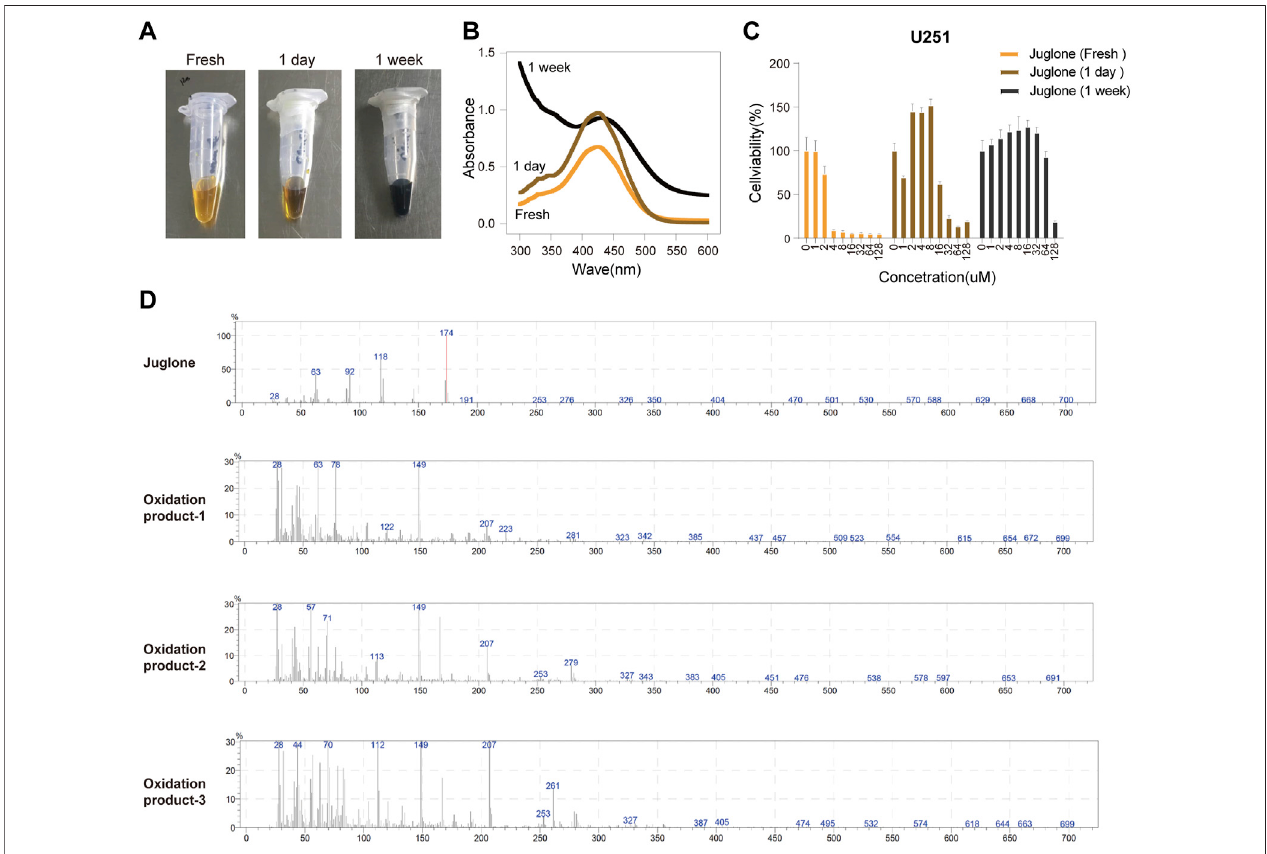
FIGURE1| Juglonewasoxidizedinatime-dependentmanner. (A) Adarkbrowncolorchangeofjugloneoccurredinatime-dependentmanner. (B) Themaximum absorbance wavelength widened as juglone was oxidized. (C) The cytotoxic effects of juglone decreased dramatically after being oxidation. (D) Mass spectrometry revealed several unknown oxidation products of